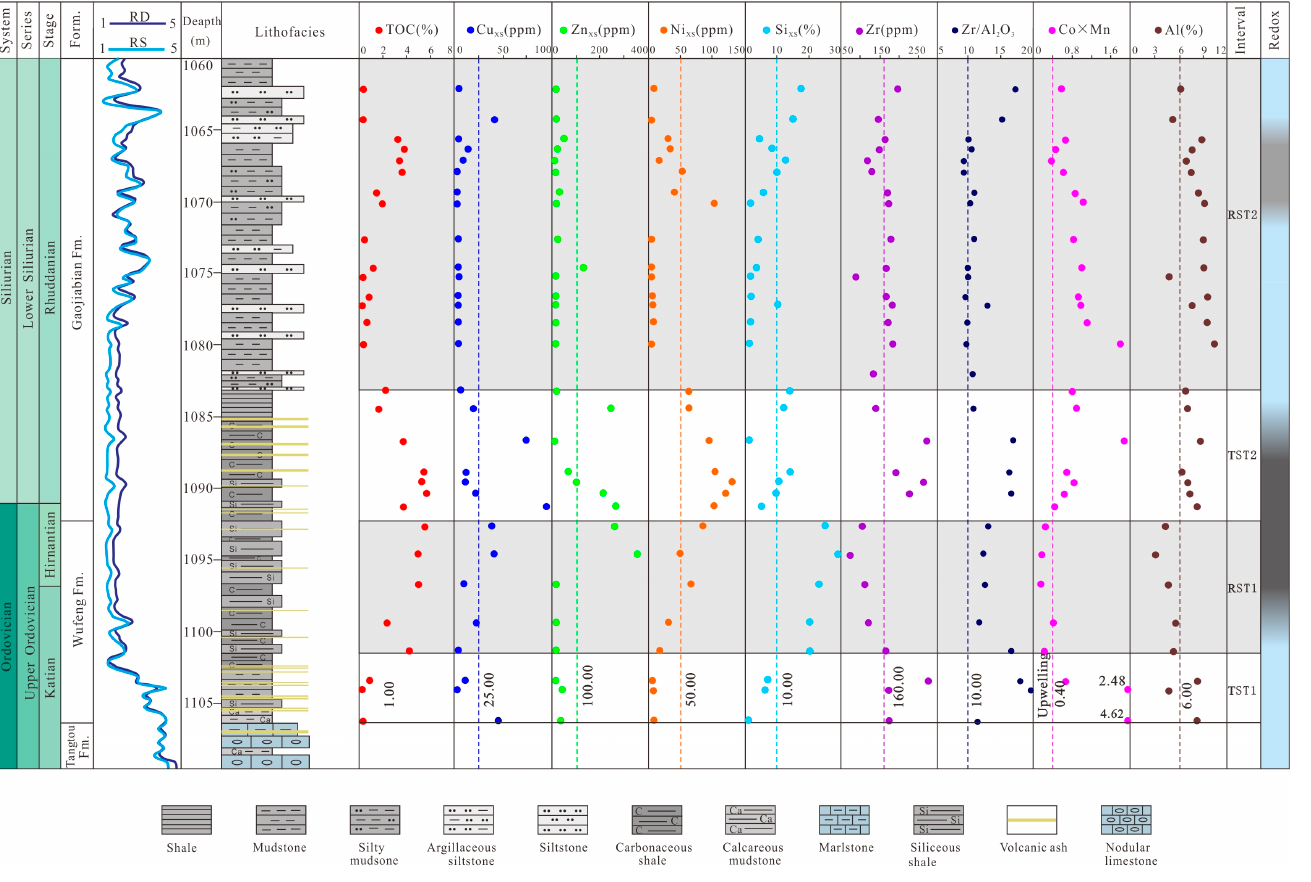
Figure 5. Vertical variations of proxies of primary productivity (TOC, Zn XS , Cu XS , Ni XS , and Si XS ), volcanic activity (Zr and Zr/Al 2 O 3 ratios), terrigenous input (Al contents), and upwelling currents (Co × Mn) in Well SY1.